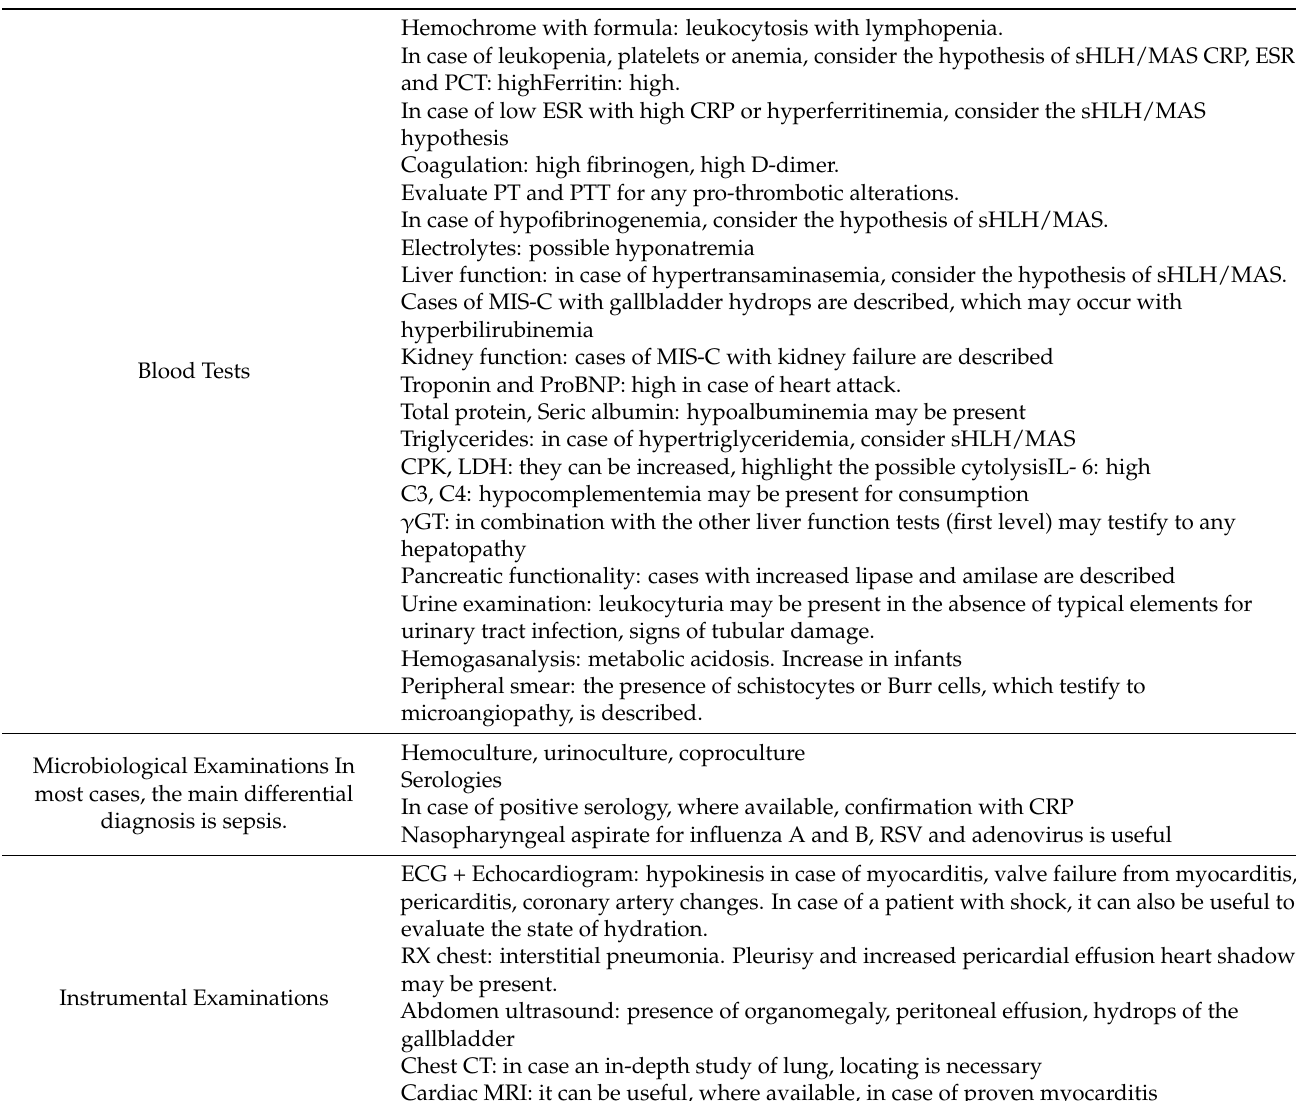
Table 4. Laboratory/instrumental tests in progress of multisystemic inflammatory syndrome (MIS-C).